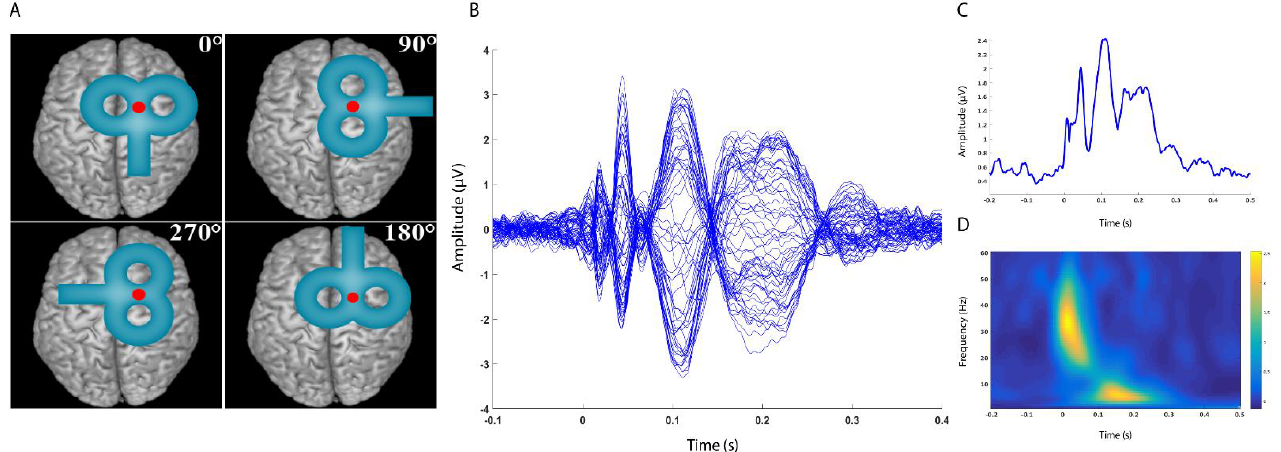
Figure 1. Panel ( A ): Experimental protocol. Single–pulse TMS was applied on the right pre–SMA using four different coil orientations (0 ◦ , 90 ◦ , 180 ◦ , 270 ◦ ), starting with the coil handle pointing posteriorly on the transverse plane and proceeding counterclockwise). For each coil orientation, three stimulation intensities were used (100%, 120% and 140% of the RMT). Panel ( B ): Example of TEP obtained by averaging signals from all subjects in the 0 ◦ CO and 140% SI condition. Each line represents a signal from one electrode; all 62 recording electrodes are plotted. Panel ( C ): Example of LMFP obtained by averaging signals from all subjects in the 0 ◦ CO and 140% SI condition. Panel ( D ): Example of TRSP obtained by averaging signals from all subjects in the 0° CO and 140% SI condition.